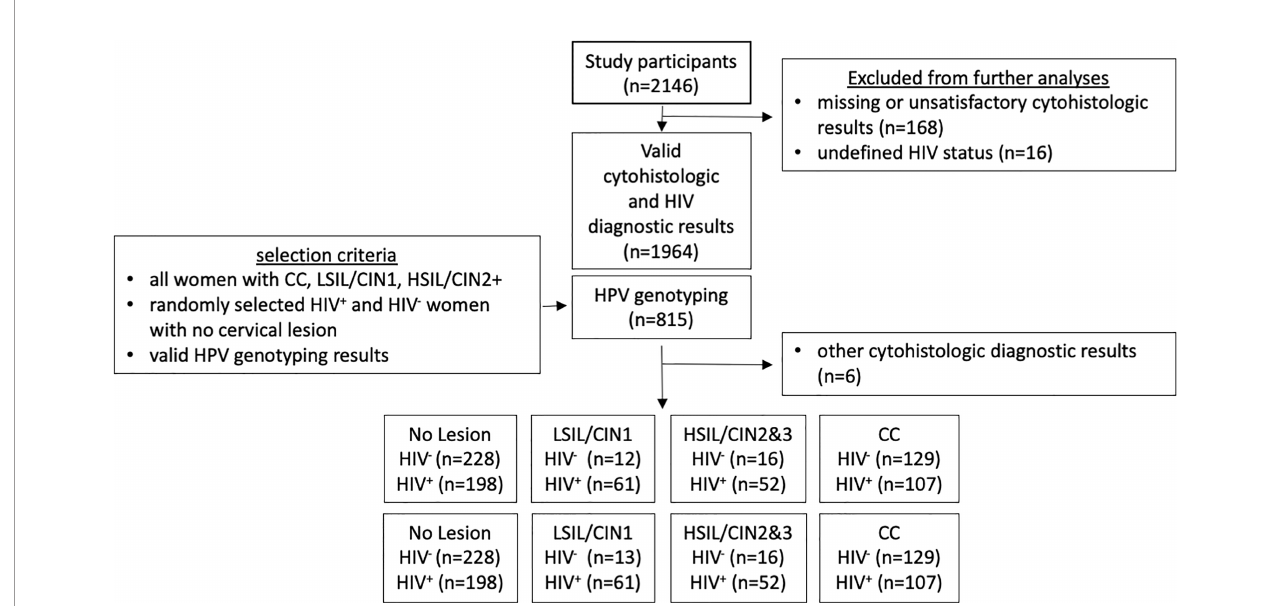
FIGURE 1 | Flow Diagram of subjects included for HPV genotyping analyses. A total of 2,146 women were screened during the 2H study, including patient referrals with cervical cancer and women with a positive visual inspection with acetic acid result during cervical cancer screening program. Valid cytohistologic diagnoses based on Pap smear and/or histology was obtained for 1,964 of these women. HPV genotyping was then performed for 815 women and to include all cervical cancer cases, all women with cervical intraepithelial lesions, as well as the similar number of women living with or without HIV and with no